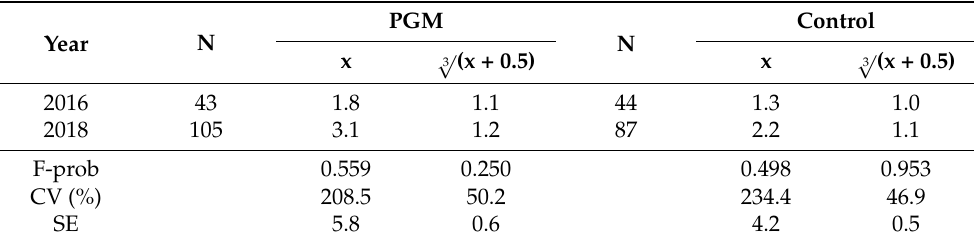
Table 1. Mean seed set per 100 fruits per bunch after pollination with and without pollen germination media on ‘Enzirabahima’ in the years 2016 and